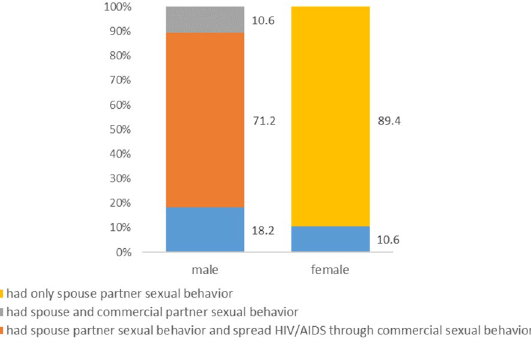
Figure 4. Sexual behaviors of 66 couples who had sexual behavior with spouse (N = 66).